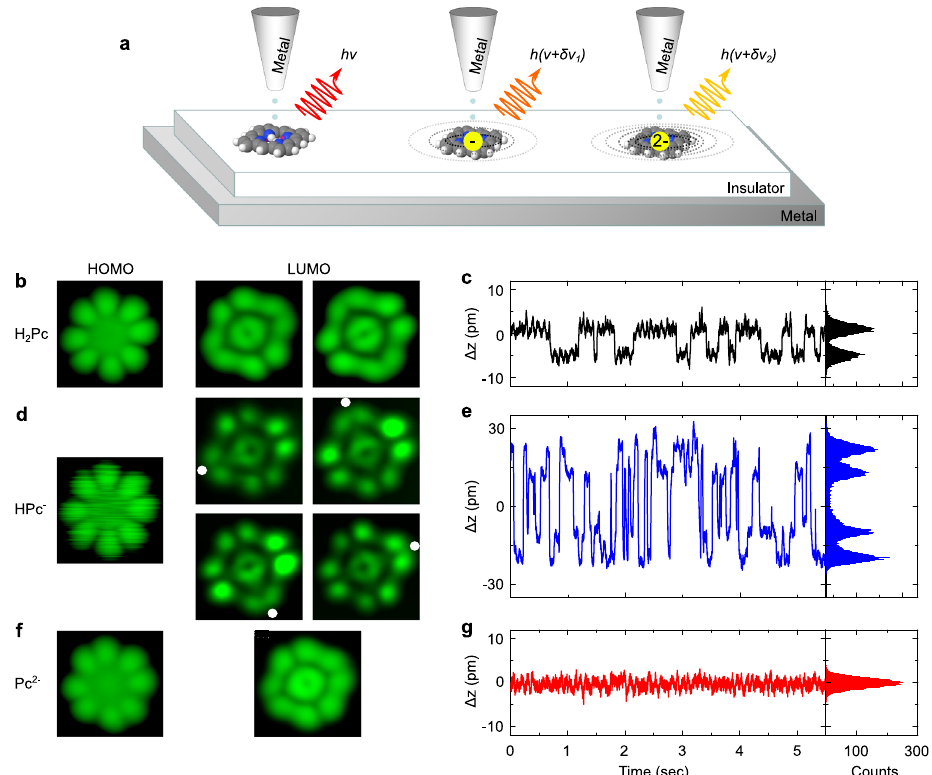
Fig. 1 Imaging protonated and deprotonated phthalocyanine molecules and monitoring tautomerization processes. a Sketch of the experiment where the fl uorescence energy ( h ν ) of a phthalocyanine molecule is progressively Stark-shifted ( δ h ν i ) by charges located at the center of the chromophore. b , d , f STM images (2.7 × 2.7 nm 2 ) of a phthalocyanine molecule on 3ML-NaCl/Ag(111). The images of the HOMO were all recorded at I = 10 pA, with voltage V = − 2.5 V for H 2 Pc, V = − 1.5 V for HPc − and V = − 2 V for Pc 2 − . The LUMO were recorded at I = 10 pA, V = 0.5 V for ( b ) H 2 Pc, I = 2.3 pA, − reveal two and four different patterns, respectively, in V = 1.43 V for ( d ) HPc − and I = 10 pA, V = 1.65 V for ( f ) Pc 2 − . The LUMO images of H 2 Pc and HPc successive images. The dots in the LUMO images of HPc − indicate the side where the remaining hydrogen atom is located. c , e , g Relative tip-sample distance ( Δ z) time traces and their histograms recorded at a bias voltage of − 2.5 V on ( c ) H 2 Pc, ( e ) HPc − , and ( g ) Pc 2 − , and at constant current (I set − point = 10 pA for H 2 Pc and 5 pA for HPc − and Pc 2 −